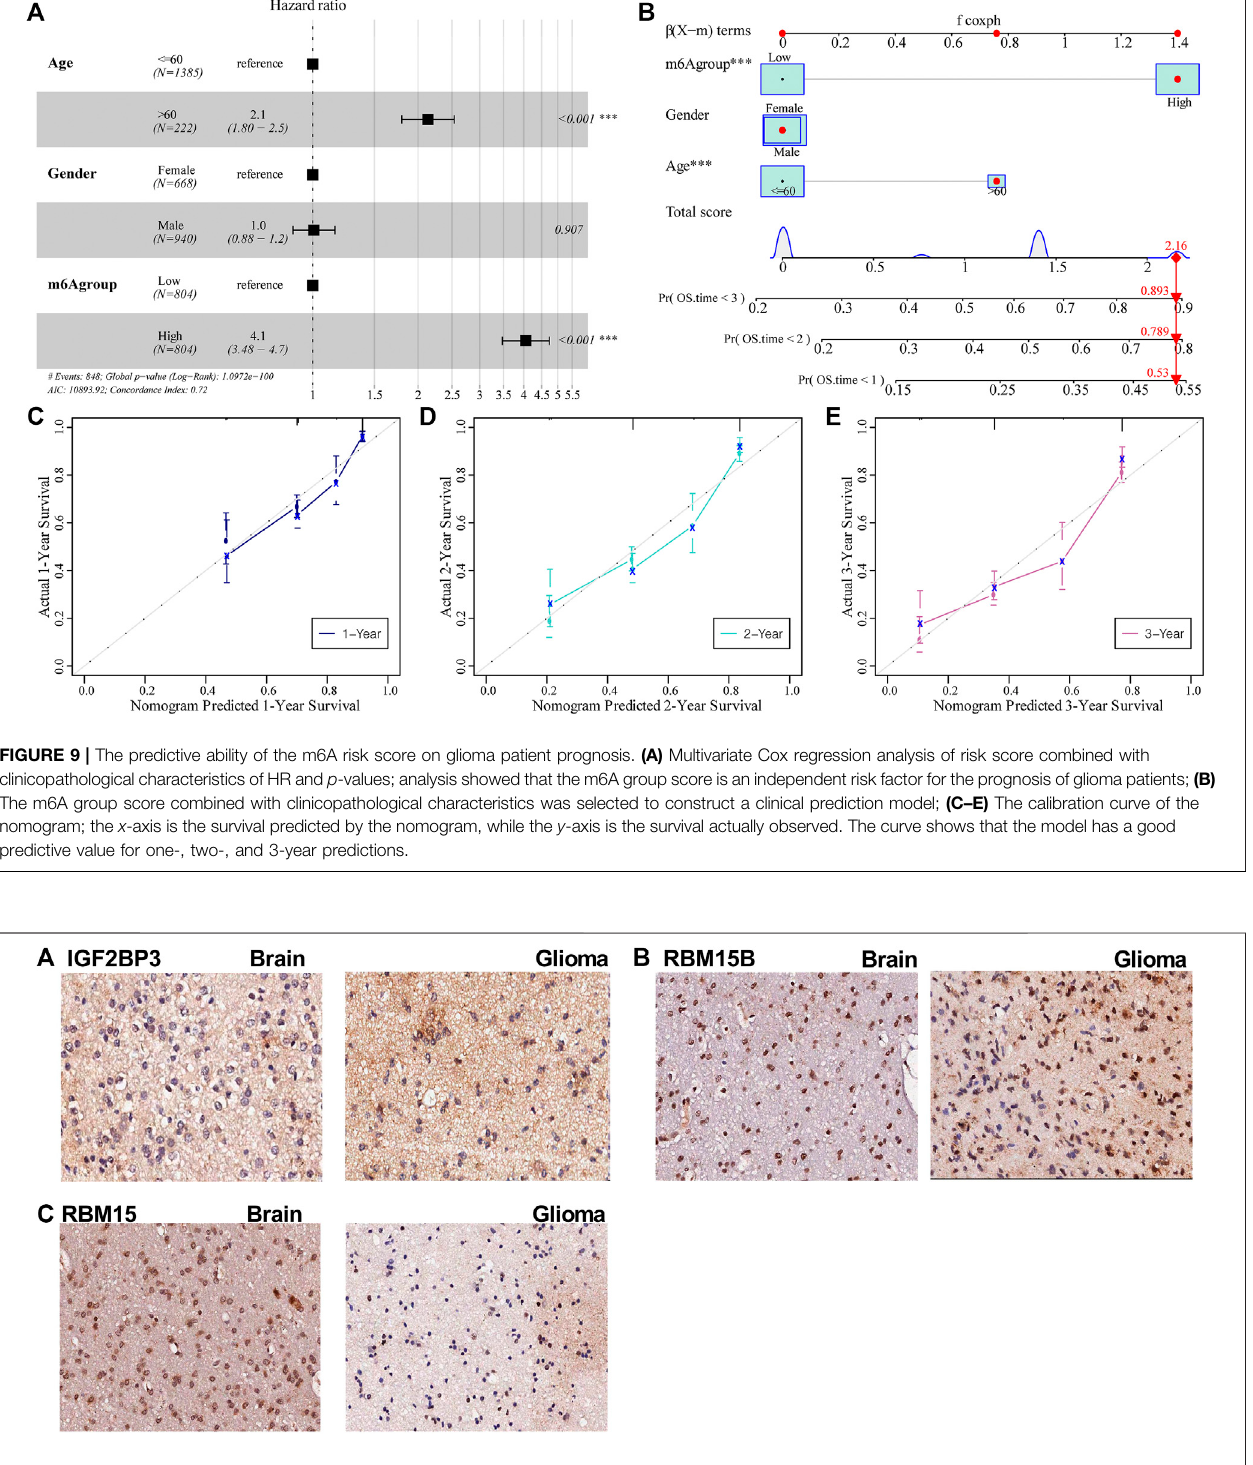
Frontiers in Genetics |